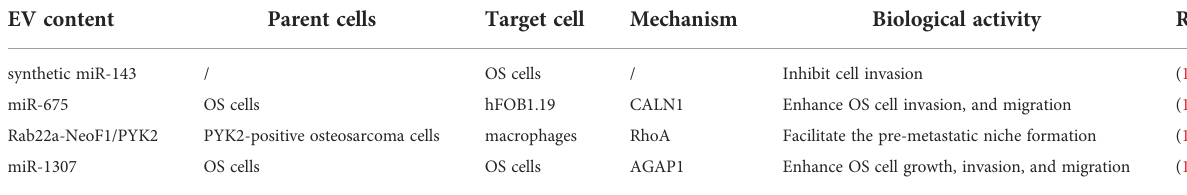
TABLE 2 Biological functions of exosomes during the metastasis of OS. EV content